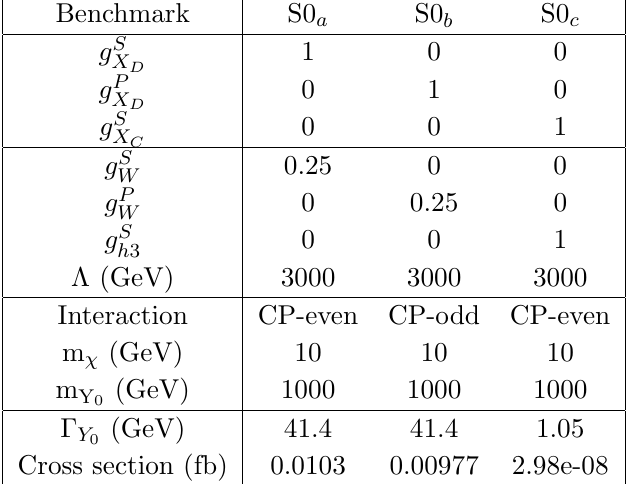
Table 1 . Benchmark scenarios with a spin-0 mediator.